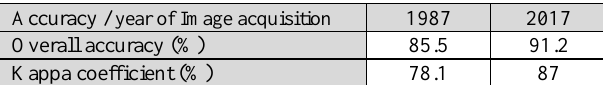
Table 9. Image classification accuracy assessment